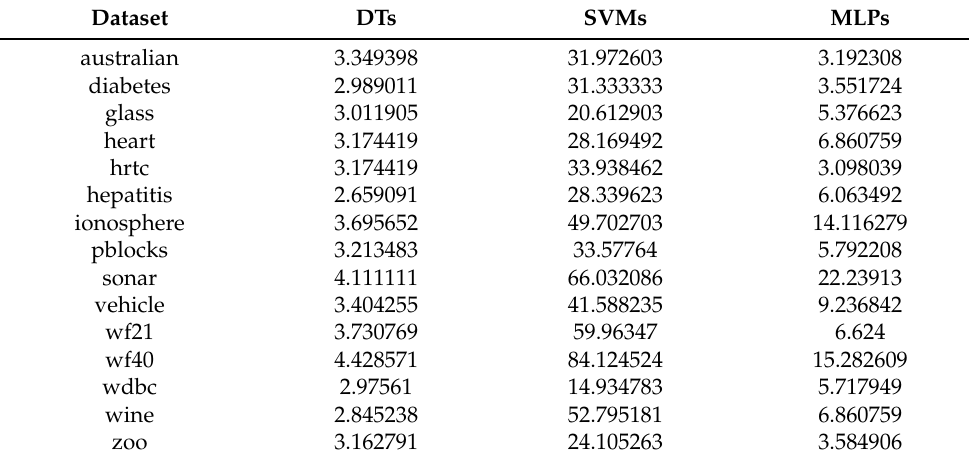
Table 9. Processing latency reduction in SRMLC compared to RMLC